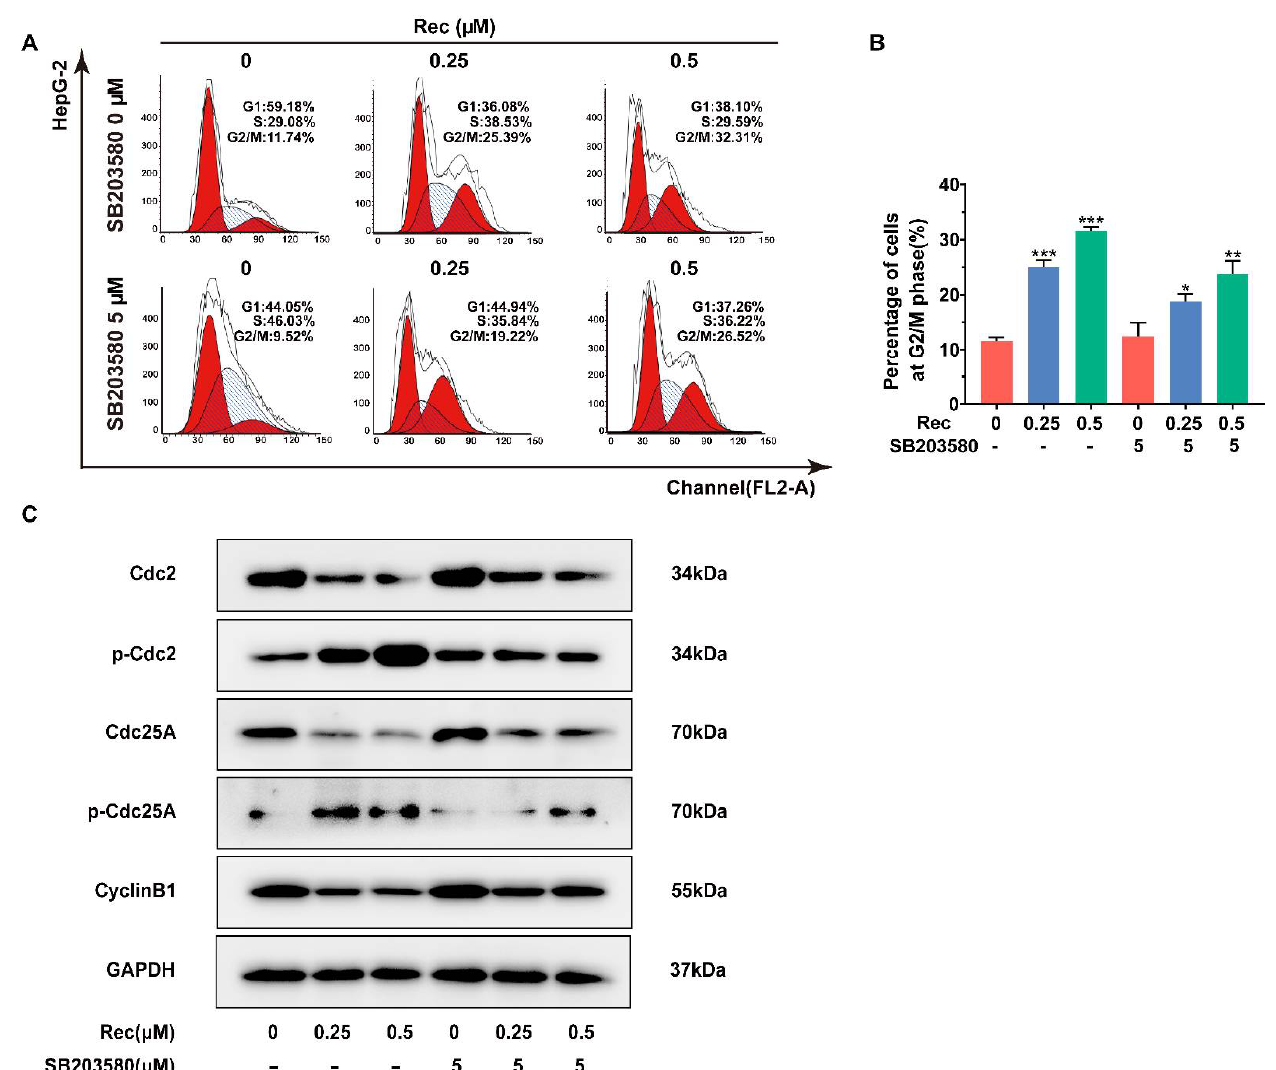
Figure 5. The p38 MAPK inhibitor SB203580 suppressed cycle arrest induced by resistomycin in HepG2 cells. ( A , B ) The ratios of G2/M phase cells treated with resistomycin (with or without 5 μM SB203580) were detected by flow cytometry (each phase presented as G1-S-G2/M: red-stripes-red). ( C ) HepG2 cells pre-treated with or without 5 μM SB203580 for 1 h and exposed to various concentrations of resistomycin for another 24 h, then analyzed by western blotting to measure the alteration of proteins related to cell cycle arrest. * p < 0.05, ** p < 0.01 and *** p < 0.001 versus 0 μM resistomycin.